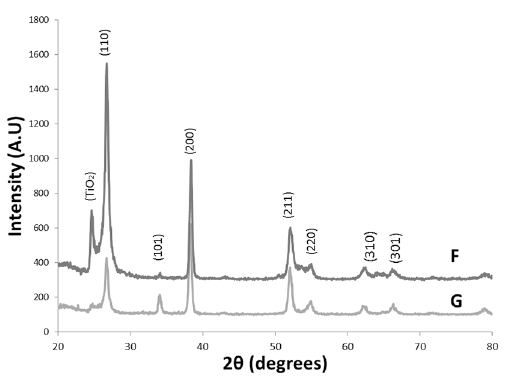
samples (A and B). 2